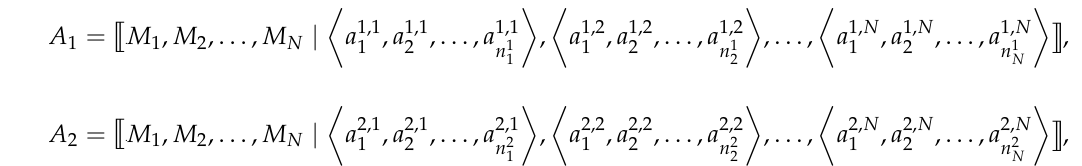
Figure 3. An example of two incompatible aggregates.